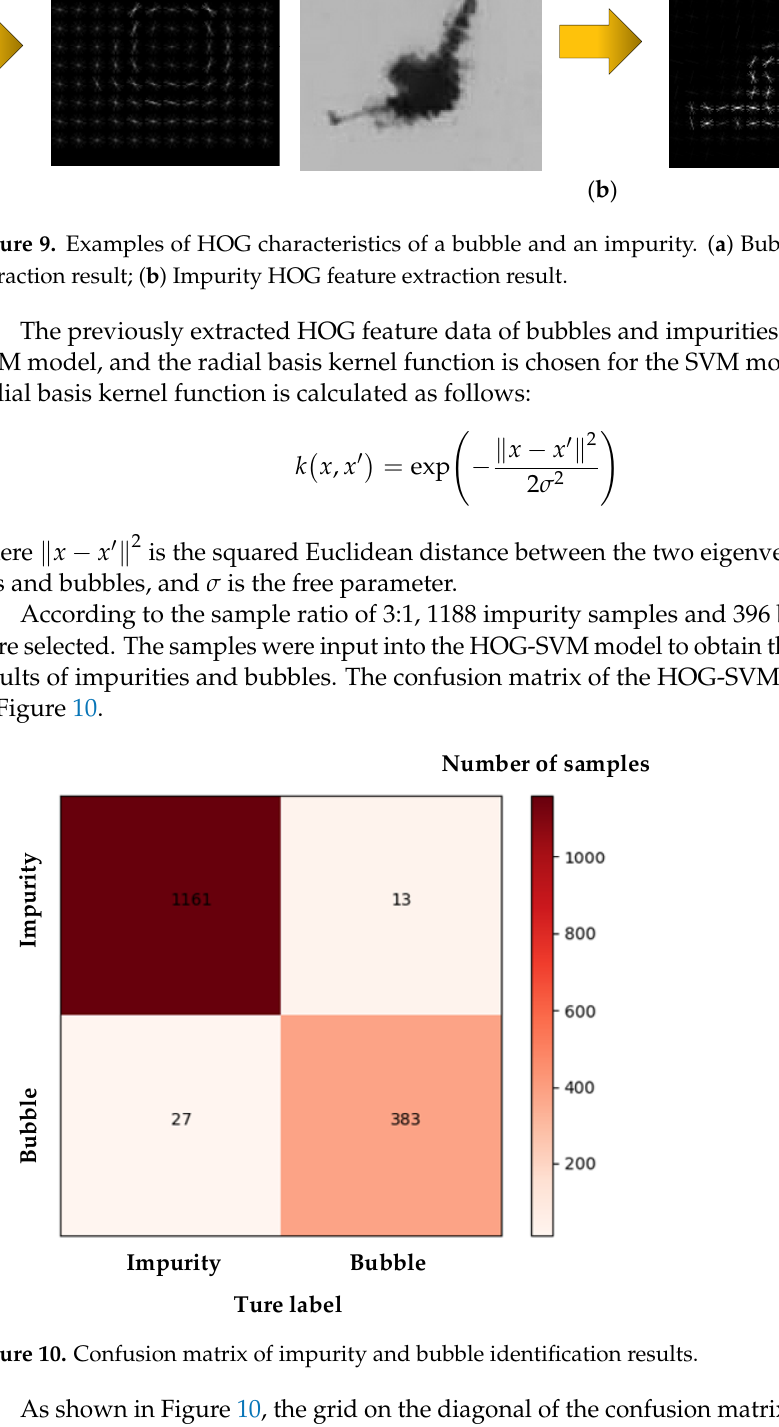
N Figure 8. Flow diagram of HOG-SVM recognition algorithm.